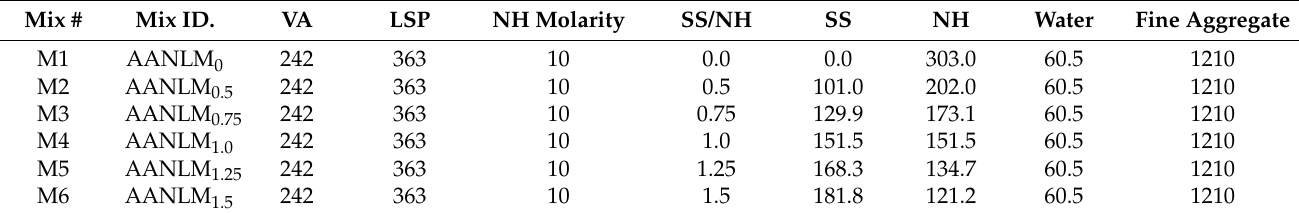
Table 2. Materials required in kg/m 3 of alkali-activated volcanic ash/limestone powder mortar. Mix # Mix